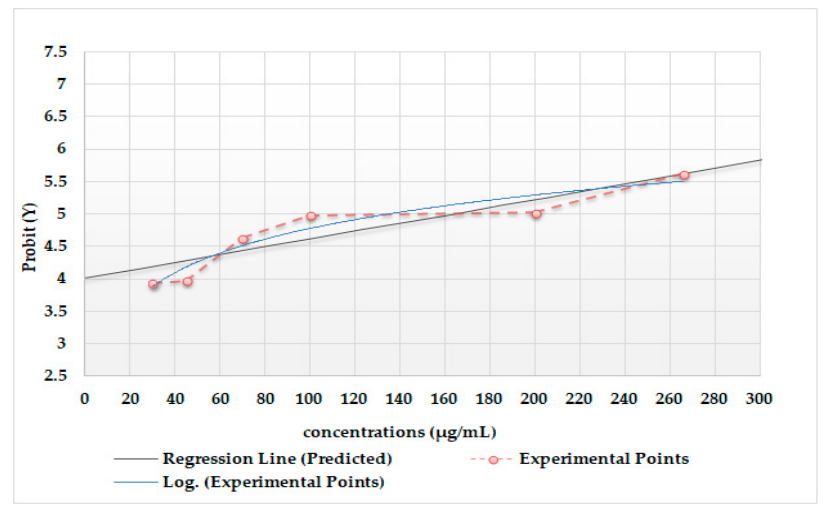
Figure 2. Concentration–effect correlation through Probit analysis for Usnea barbata (L.) F. H. Wigg. dry extract using Brine Shrimp Lethality assay (regression statistics and predicted points: LC 50 = 164.92 µg/mL; LD 50 Standard Error = 13.70 µg/mL; LD 50 LCL = 129.40 µg/mL; LD 50 UCL = 200.43 µg/mL; LC 80 = 330.13 µg/mL; LC 100 = 412.74 µg/mL).